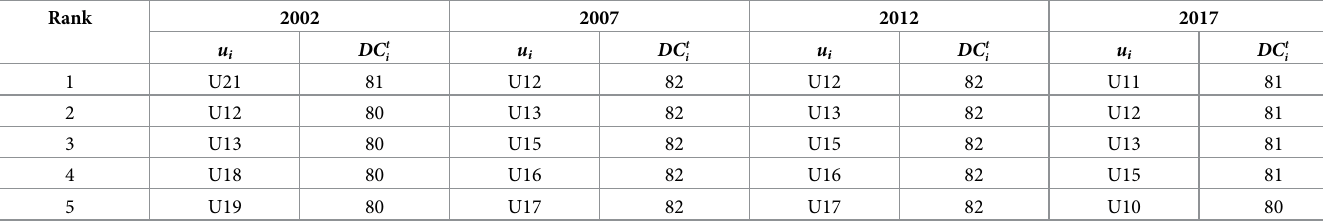
Table 2. Top 5 industries with degree